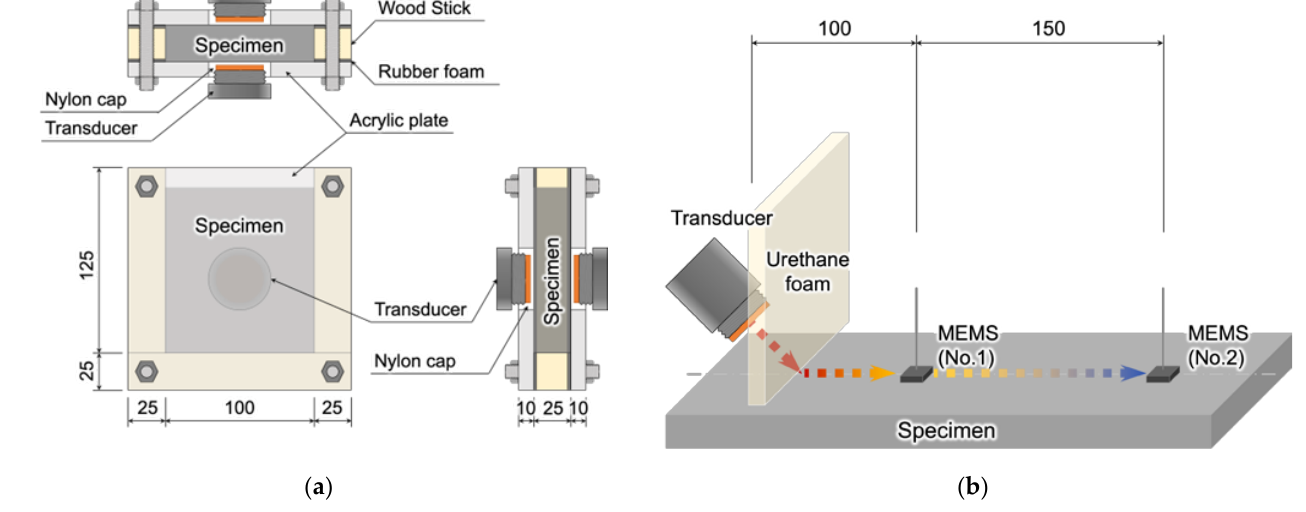
Figure 2. Setup for testing ( a ) contact P - wave and ( b ) noncontact surface wave.